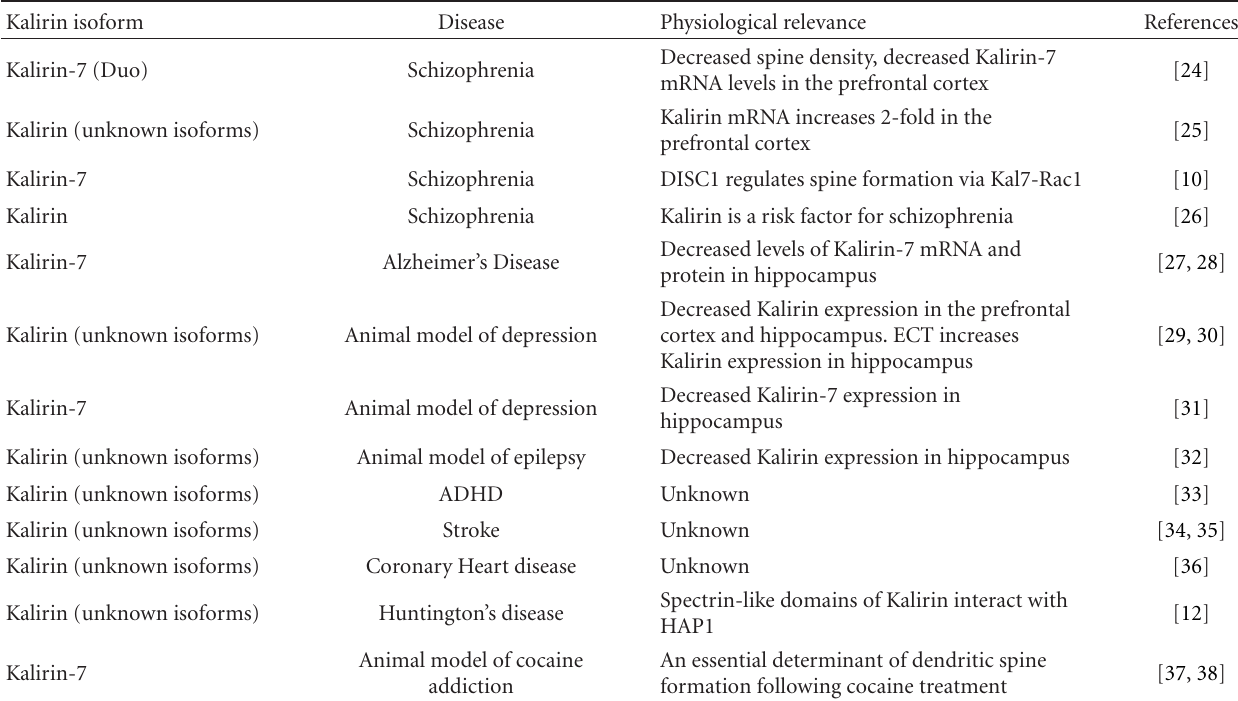
Table 1: Kalirin and human